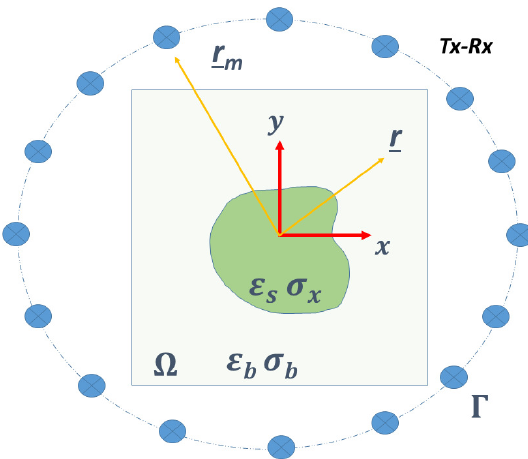
Figure 1. A sketch of the adopted multiview-multistatic measurement configuration to probe the region of interest by means of Tx-Rx primary sources (filamentary currents) placed on a circumference Γ of radius r m